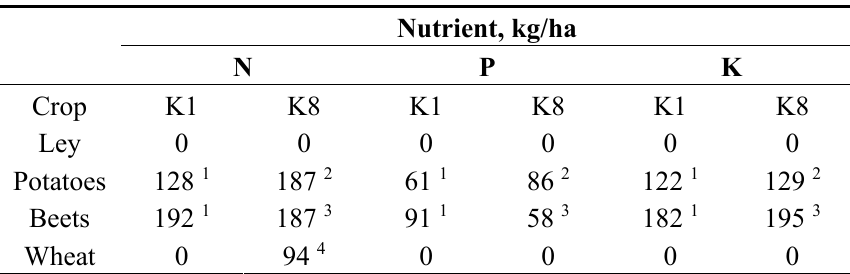
Table 1. Average supply of N, P and K in kg/ha and year to different crops in the different treatments of the K-trial